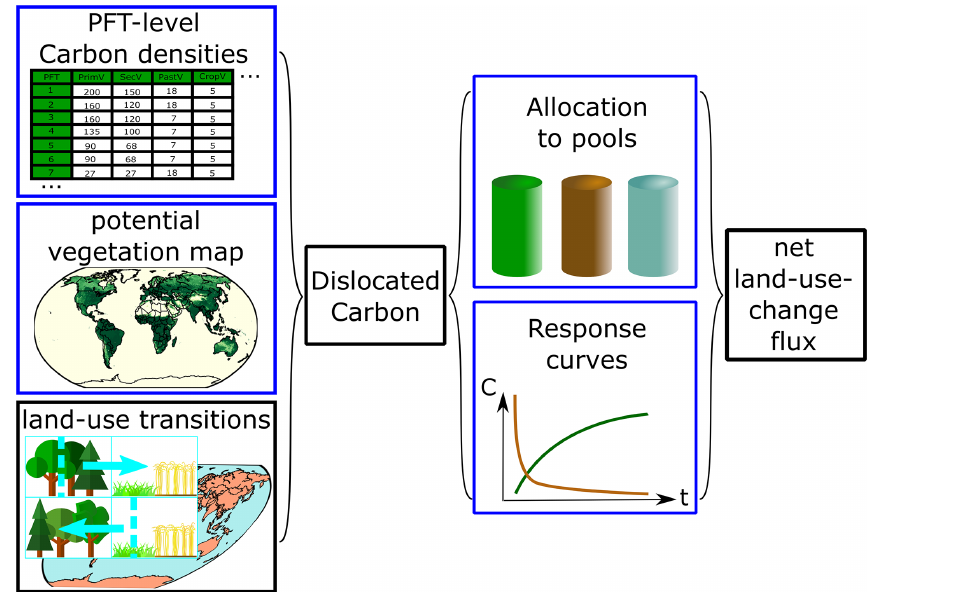
Figure 1. Schematic description of the BLUE model set up and of the changes made in each of the factorial simulations (highlighted in blue boxes and summarised in Table 2). The model is forced by a map of grid-cell-level land-use transitions occurring at time t (gross vs. net). These are then combined with a potential vegetation map of 11 natural vegetation types (Table A1), each having specific carbon densities in vegetation and soil pools (Cdens), to calculate the carbon dislocated by each transition. The mass of dislocated carbon is then distributed among different slash and product pools (Alloc), with specific response curves with different decay times ( t